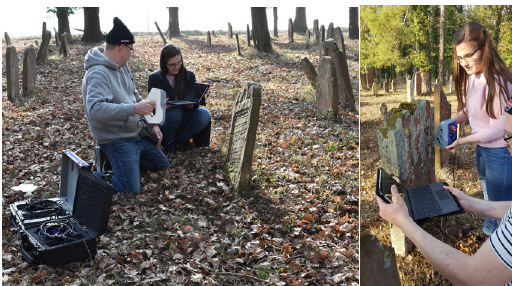
Figure 7. Handheld scanning handheld structured light scanner with Artec EVA (left) and Artec Spider